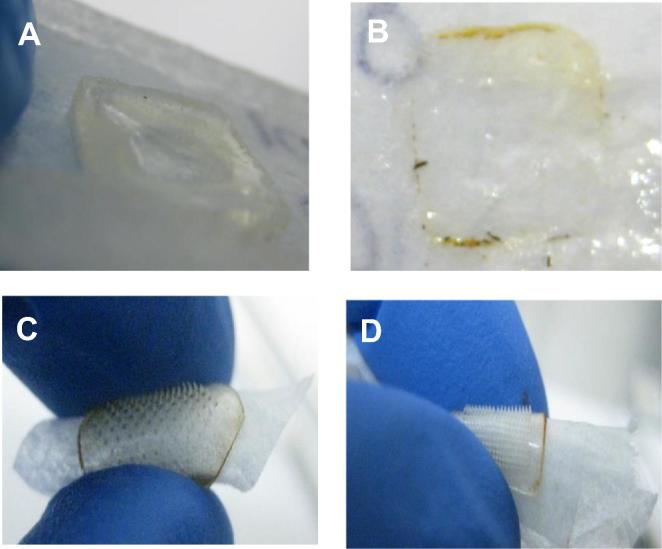
Dissolving 58 kDa PVP MN arrays dissolved after 24 hours’ skin insertion in mouse skin in vivo (A) and dissolved Gantrez® S-97 MN arrays after 24 hours’ skin insertion in mouse skin in vivo (B). Hydrogel-forming MN arrays after removal following 24 hours’ skin insertion in mouse skin in vivo displayed flexibility due to the uptake of interstitial fluid regardless of whether the needle density used was 11 × 11 (C) or 19 × 19 (D).